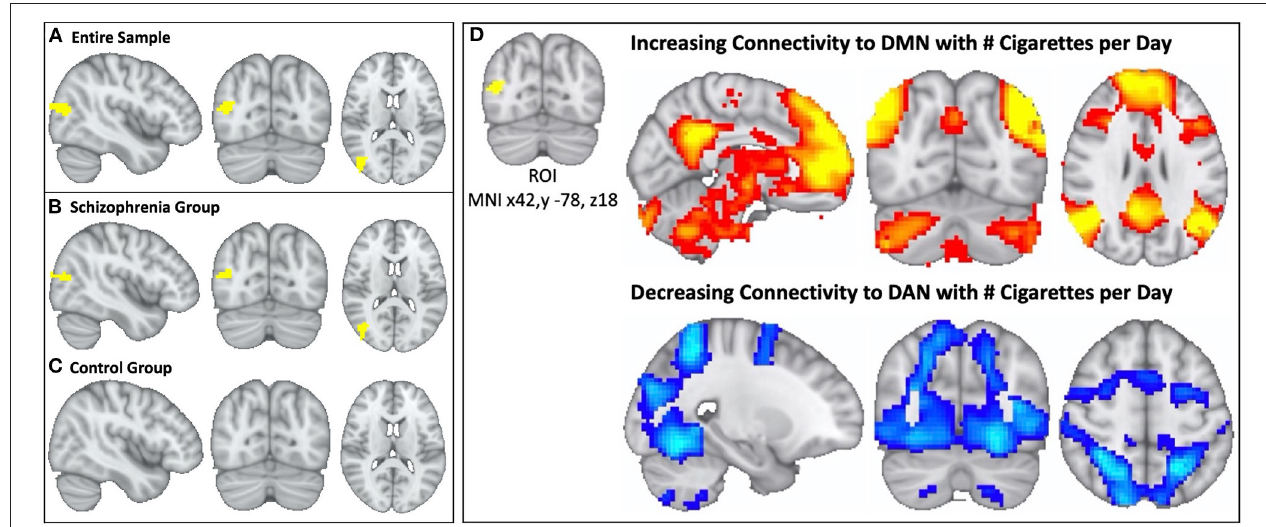
FIGURE 2 | In schizophrenia, individual variation in DMN topography is linked to cigarette consumption: higher cigarette consumption is linked to both increased connectivity between parieto-occipital ROI and DMN and decreased connectivity between parieto-occipital ROI and the DAN. We identified a parieto-occipital region (Thresholded voxelwise p < 0.001, Cluster k = 77, MNI x42, y − 78, z18, p < 0.05) where functional connectivity correlates with daily cigarette use in our combined sample of schizophrenia and control smokers (A) . In this region, increased functional connectivity correlates with greater daily cigarette consumption. We repeated this analysis in each diagnostic sub-group and observed a significant relationship between connectivity and cigarette use in the schizophrenia group (Cluster k = 52, p < 0.05) (B) but not in the neurotypical group (C) . After identifying the parieto-occipital region where functional connectivity correlated with daily cigarette use, we conducted follow-up seed-based connectivity analysis to examine the spatial pattern of how connectivity to this region correlates with nicotine consumption in the schizophrenia group. We observed that global functional connectivity to this region was positively correlated with the DMN and negatively correlated with the DAN (D) , which was readily apparent by visual inspection. Higher cigarette consumption was linked to both increased connectivity between the parieto-occipital ROI and DMN and decreased connectivity between the parieto-occipital ROI and the DAN.